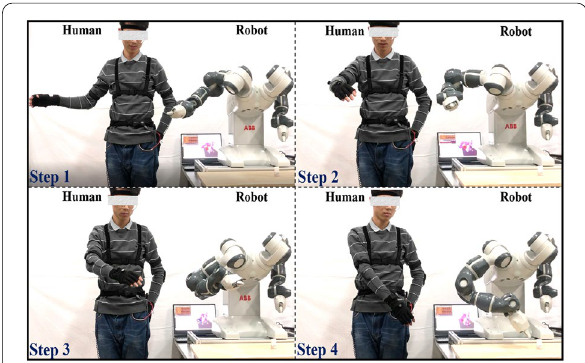
Figure 3 Motion capture and control between human and